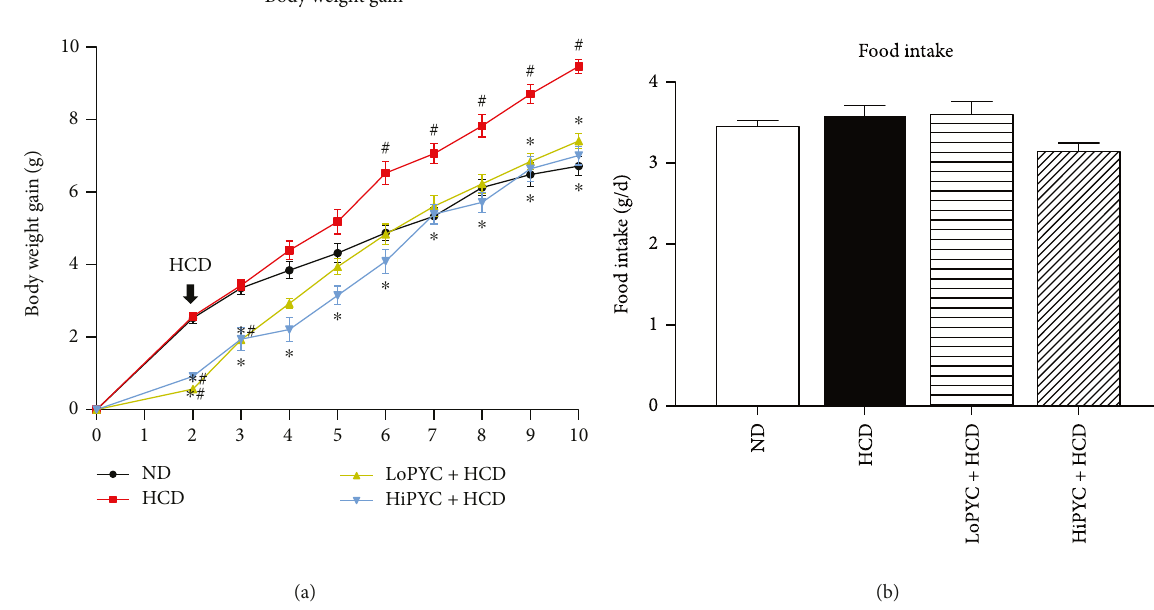
Figure 1: PYC lowered body weight gain. (a) Change in body weight gain and (b) daily food intake. The data are expressed as the means ± SE for 20 to 25 mice per group. # p < 0 05 versus the ND group; ∗ p < 0 05 versus the HCD